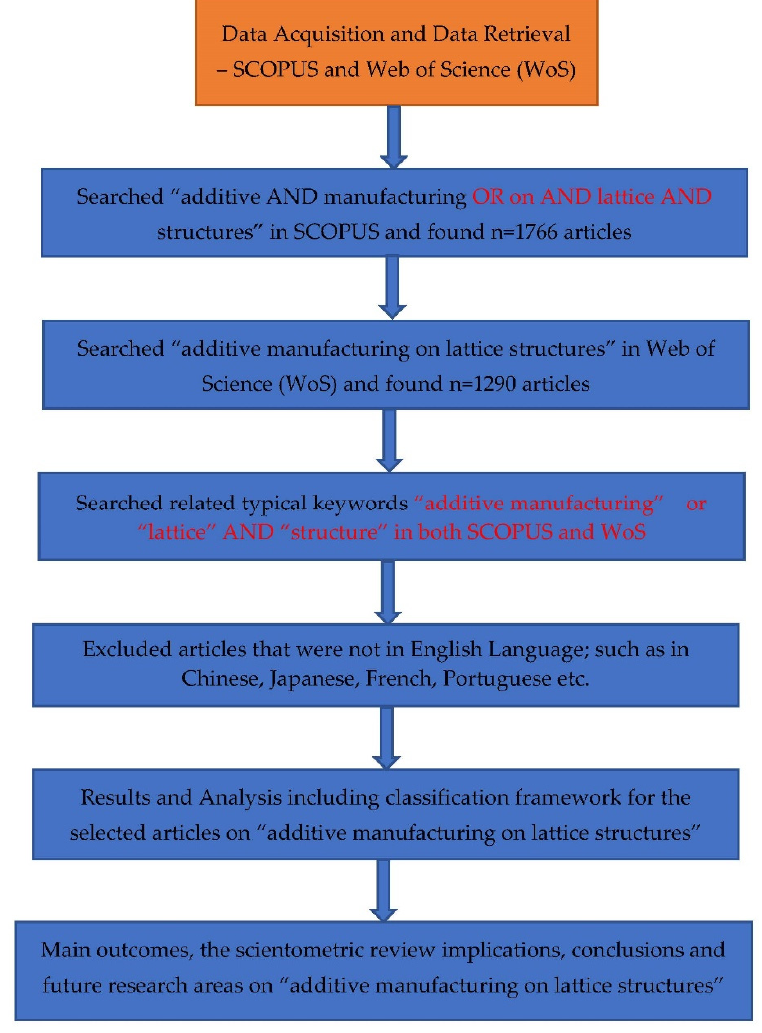
Figure 2. Research methodology on the scientometric study.